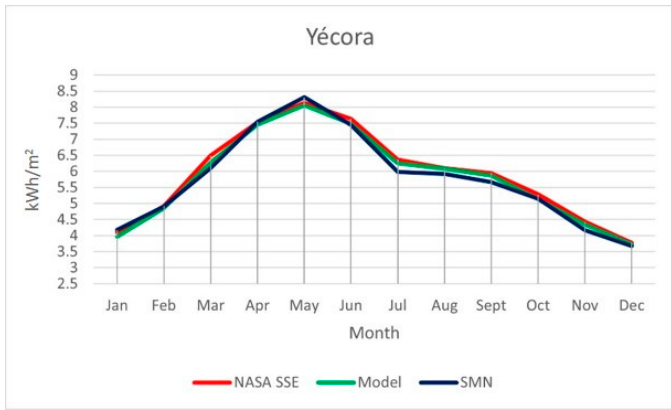
Figure 6. Comparison between the SMN, NASA SSE, and the model for the station of Yécora.